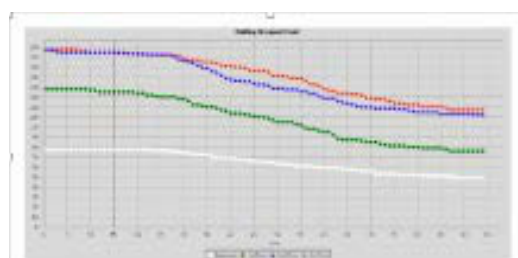
Figure 9. Line Chart visualization of the GAMA simulation